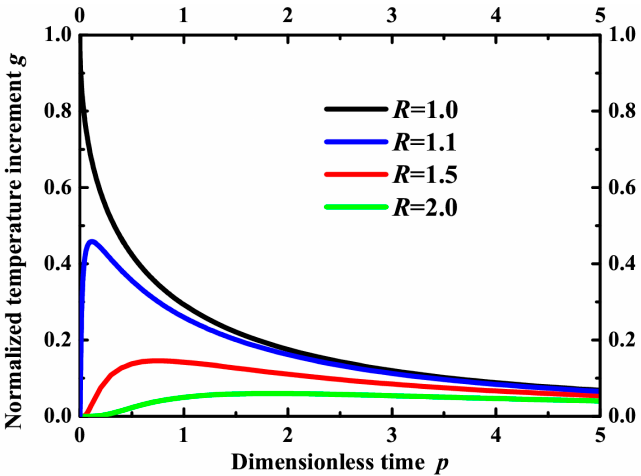
Figure 5. Evolution of normalized temperature g as a function of dimensionless time p in different points of the polymer matrix surrounding a gold nanoparticle: R = 1 (black line), R = 1.1 (blue line), R = 1.5 (red line) and R = 2 (green